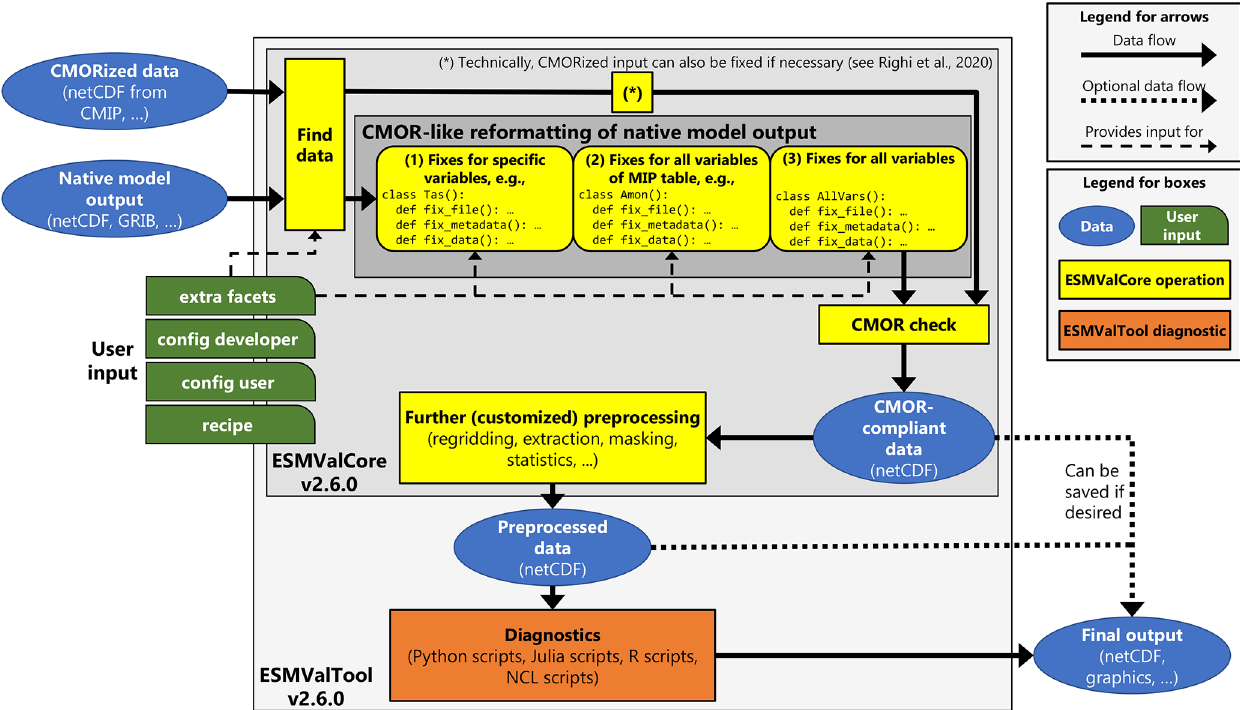
Figure 1. Schematic representation of ESMValTool v2.6.0. Originally, ESMValTool was designed to process CMORized output from CMIP (top left blue ellipse). Here, we describe additions that allow reading and processing native model output (bottom left blue ellipse) with ESMValTool through a CMOR-like reformatting (yellow round rectangles) within the ESMValCore preprocessing pipeline. As a result, the data are fully CMOR-compliant after this initial preprocessing step and can be processed by the diagnostic scripts (orange box) just like any other input dataset. The diagnostic scripts do not need to treat native model output in any special way. Note that to reduce the complexity of this schematic, only those dashed arrows that are relevant for this paper are